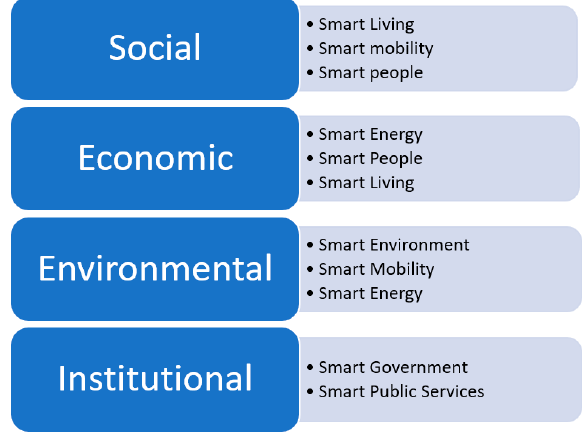
Figure 3. Dimensions of sustainability versus areas in a smart city [3].